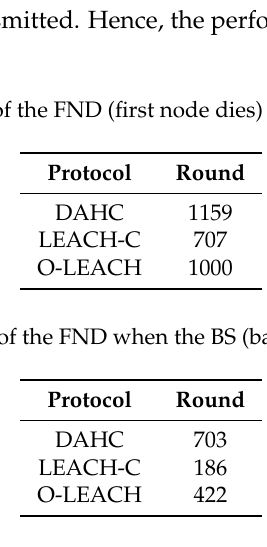
Figure 8. The residual energy of nodes versus rounds when the BS is outside.